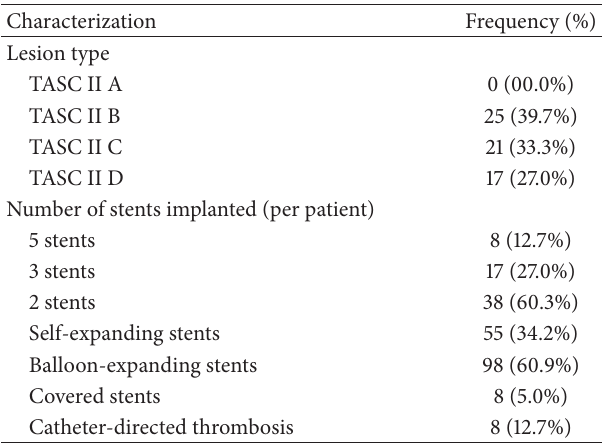
Table 3: Lesion and procedure